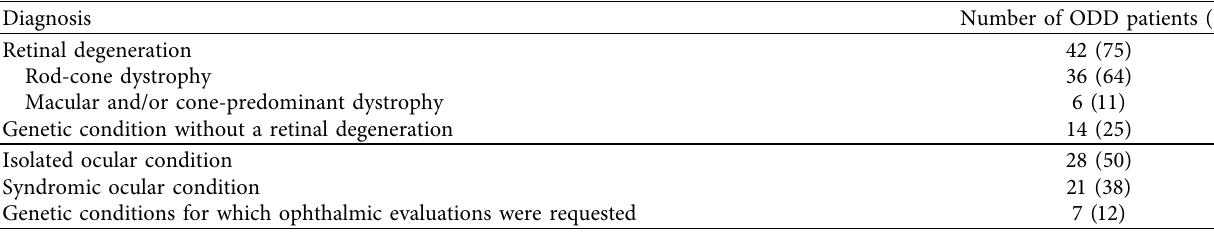
Table 1: ODD cohort diagnoses.